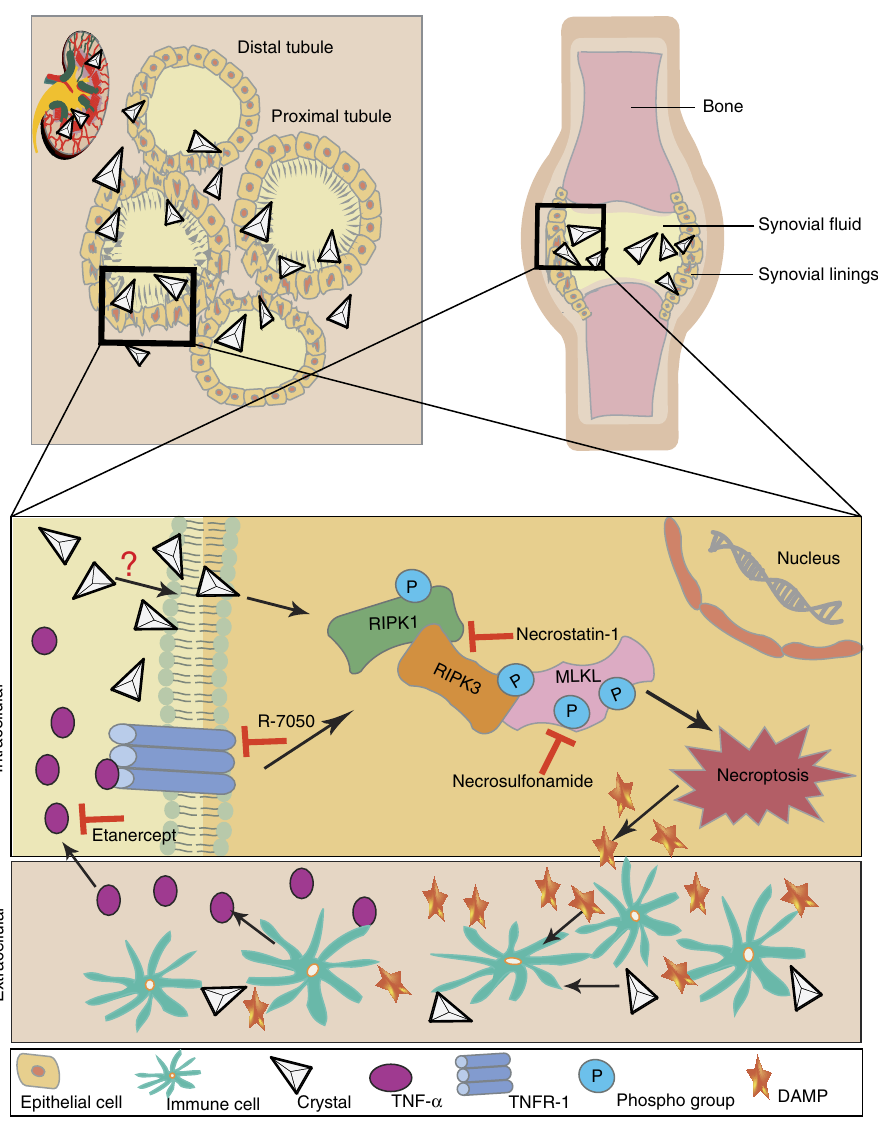
Figure 10 | Schematic illustration of crystal-induced necroptosis and inflammation (necroinflammation). During crystallophathies, crystals are formed and deposited inside the organ, for example, kidney stone disease or joint, for example, gouty arthritis. Upon crystallization, crystals are phagocytized by parenchymal cells where they activate the RIPK1, RIPK3 and MLKL pathway of necroptosis, a prototype form of regulated necrosis, by inducing a series of phosphorylation events. Cellular necroptosis lead to release of DAMPs, which activate immune cells surrounding the parenchymal cells. Activated immune cells release pro-inflammatory cytokines, for example, IL-1 b , IL-6 and TNF- a and so on. Pro-inflammatory cytokines like TNF- a can also activate the RIPK1, RIPK3 and MLKL pathway of necroptosis via TNFR1. The auto-amplification loop between cell death and inflammation, called necroinflammation, leads to aggravation of tissue injury, and if remain uncontrolled then to organ failure. In the current settings, the loop of crystal-induced necroinflammation can be blocked by using a soluble TNFR1-hIgG1 fusion protein etanercept to inhibit TNF- a , TNFR inhibitor R-7050, RIPK1 inhibitor necrostatin-1 or MLKL inhibitor necrosulfonamide. RIPK, receptor-interacting protein kinase; MLKL, mixed lineage kinase domain like; DAMPs, danger associated molecular patterns; IL, interleukin; TNF, tumour-necrosis factor; TNFR, tumour-necrosis factor 160min. Measurements were repeated at 60 and 120min after onset of reperfusion. Molecular Probes, Leiden, the Netherlands) were injected via the femoral artery Subsequently, FITC dextran was infused intra-arterial for the analysis of catheter, and their passage through the vessels of interest was recorded using the fluorescein isothiocyanate (FITC) filter cube under appropriate stroboscopic microvascular permeability. Analysis of microvascular permeability was performed illumination (exposure, 1ms; cycle time, 10ms; l ¼ 488nm), integrating video as follows 38 . The macromolecule FITC dextran (5mg in 0.1ml saline, Mr images for sufficient time ( 4 80ms) to allow for the recording of several images of the same bead on one frame. Beads that were flowing freely along the centerline of the vessels were used to determine blood flow velocity. For offline analysis of parameters describing the sequential steps of leucocyte extravasation, we used the Cap-Image image analysis software (Dr Zeintl, Germany). Animals were treated with necrostatin-1 (1.65mgkg (cid:3) 1 i.p.) or vehicle 30min before the experiment. For the analysis of postischemic leucocyte responses, three postcapillary vessel segments in a central area of the spread out cremaster muscle were randomly Assessment of renal injury . Mice kidney sections of 2 m m were stained with chosen. Ischaemia was induced by clamping all supplying vessels at the base of the cremaster muscle using a vascular clamp (Martin, Germany). After 30min of periodic acid-Schiff reagent. Tubular injury was scored by assessing the percentage ischaemia, the vascular clamp was removed and reperfusion was restored for of necrotic tubules and presence of tubular casts. Ly6B.2 þ neutrophils were